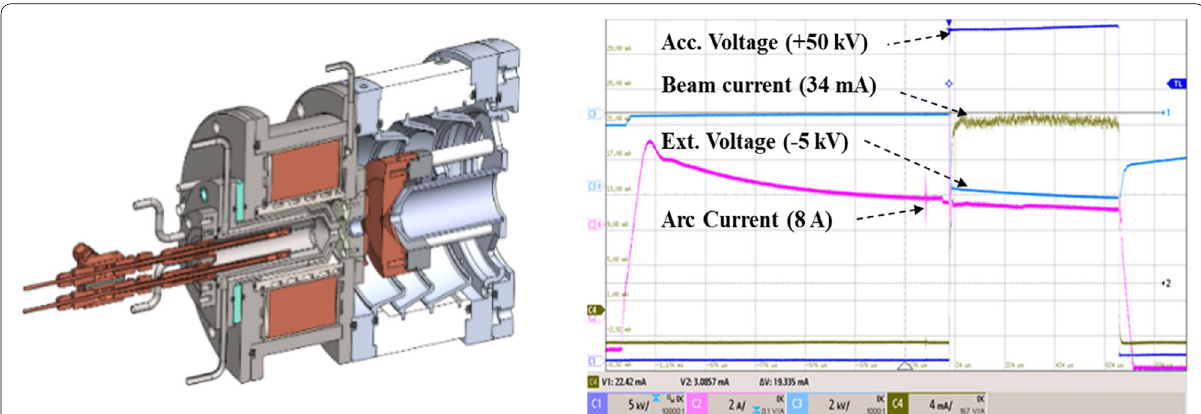
Fig. 9 (Left) Cross‑sectional view of the duo‑plasmatron ion source (50 keV, > 50 mA) and (right) typical waveforms of the main operational parameters of the pulsed ion source operation